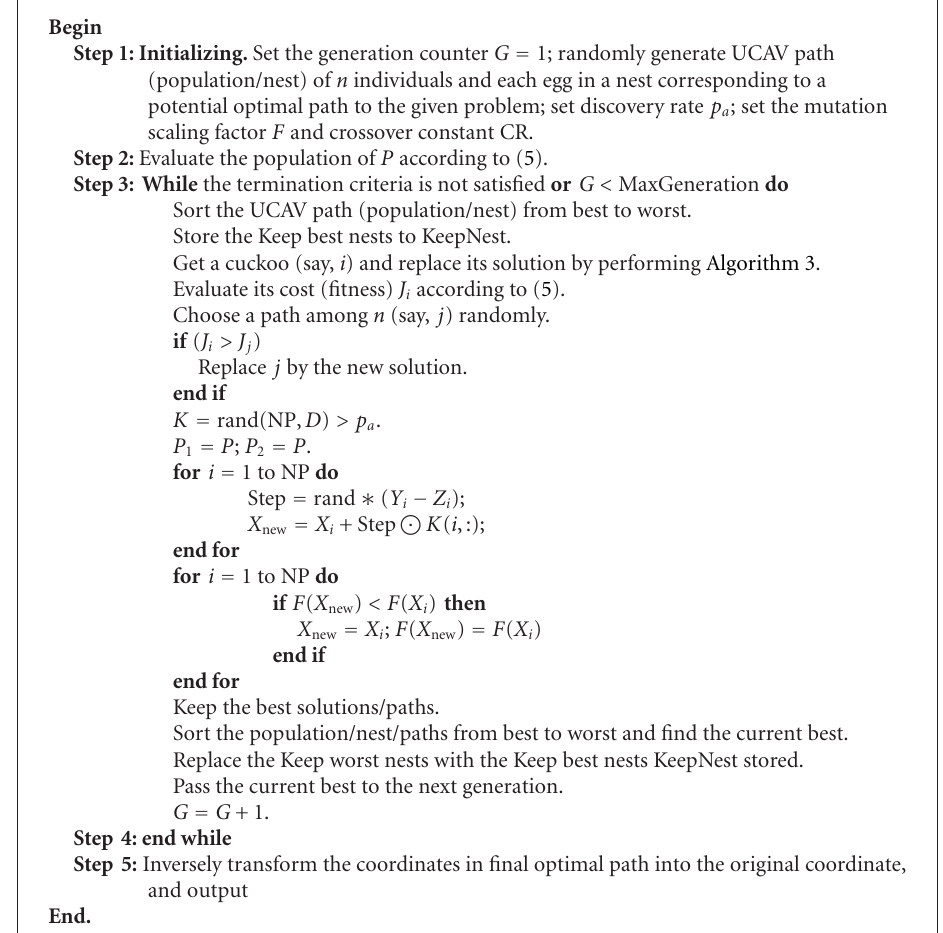
Algorithm 5: Algorithm of DE/CS for UCAV three-dimension path